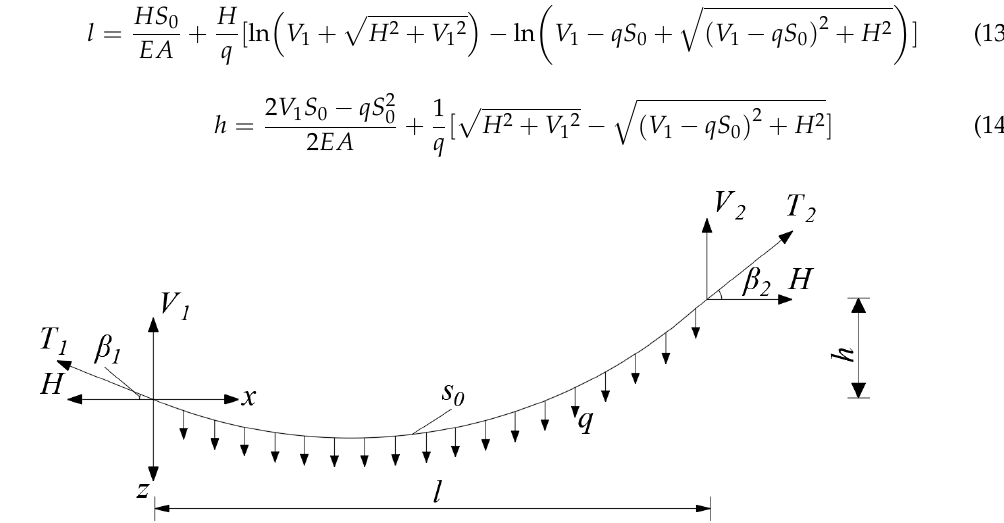
Figure 6. Catenary cable calculation model diagram.